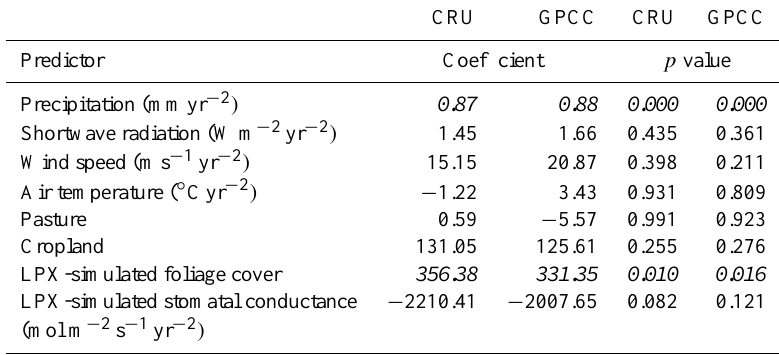
Table 4. Attribution of water balance ET trends (in mmyr − 2 ) in dry basins based on coefficients and p values from a multiple regression analysis, using CRU- and GPCC-based ET and precipitation, respectively. Significant p values ( ≤ 0.05) and coefficients are in italics.